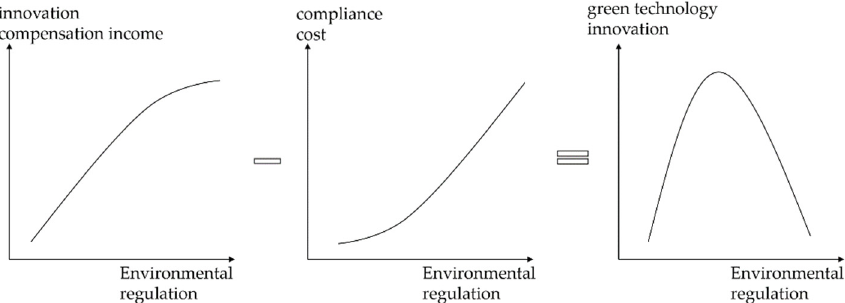
Figure 1. The additive combinations of latent mechanisms result in an inverted U-shaped relationship between environmental regulation and green technology innovation.